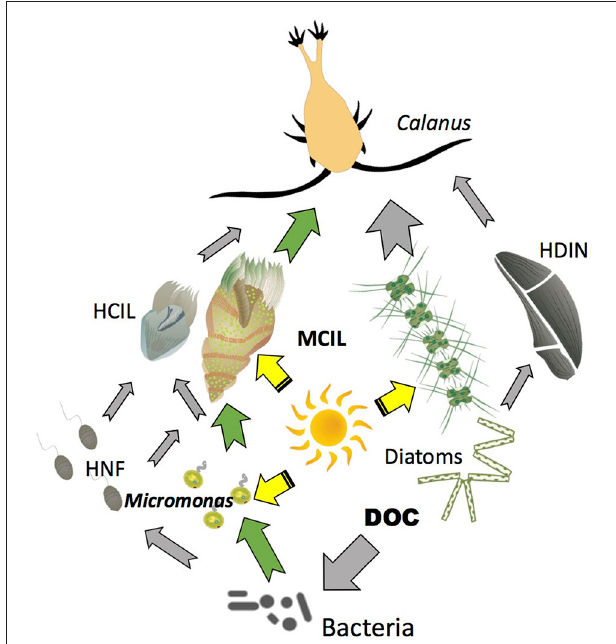
FIGURE 3 | Conceptual model of Arctic food web with mixotrophy. Yellow arrows indicate flow of energy from the sun to photosynthetic organisms (autotrophs and mixotrophs); Gray arrows indicate flow of carbon to heterotrophs; Green arrows indicate major pathways of carbon flow to or from mixotrophs. HCIL, Strictly heterotrophic ciliates; MCIL, Mixotrophic ciliates; HNF, Heterotrophic nanoflagellates; DOC, Dissolved organic carbon; HDIN, Heterotrophic